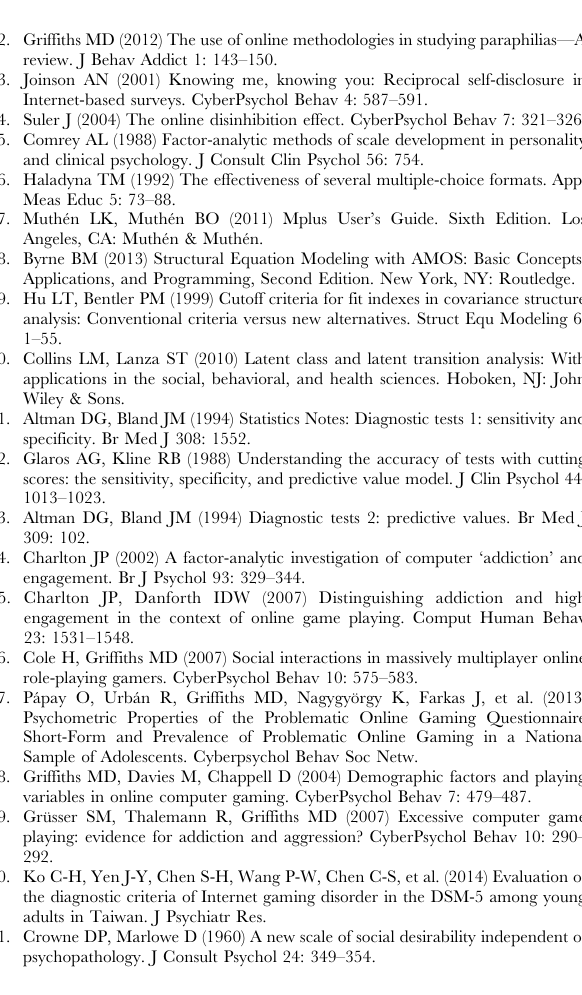
Table S1 The Internet Gaming Disorder Test, Dimen- sionality and Instructions. Table S2 Internet Gaming Disorder 9 Criteria, Instruc- tions and